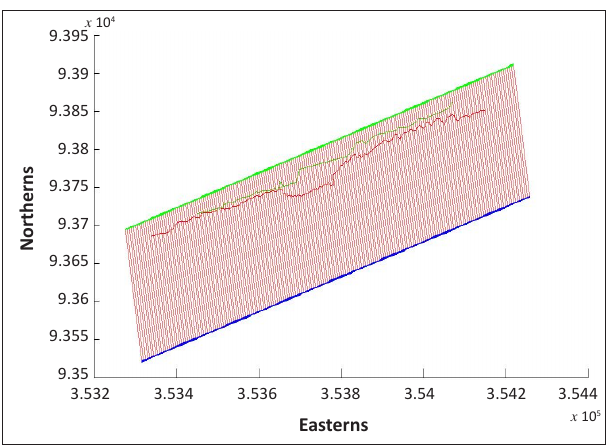
FIGURE 7: Orthogonal lines projected from a baseline for rate of change computation using the EPR method.